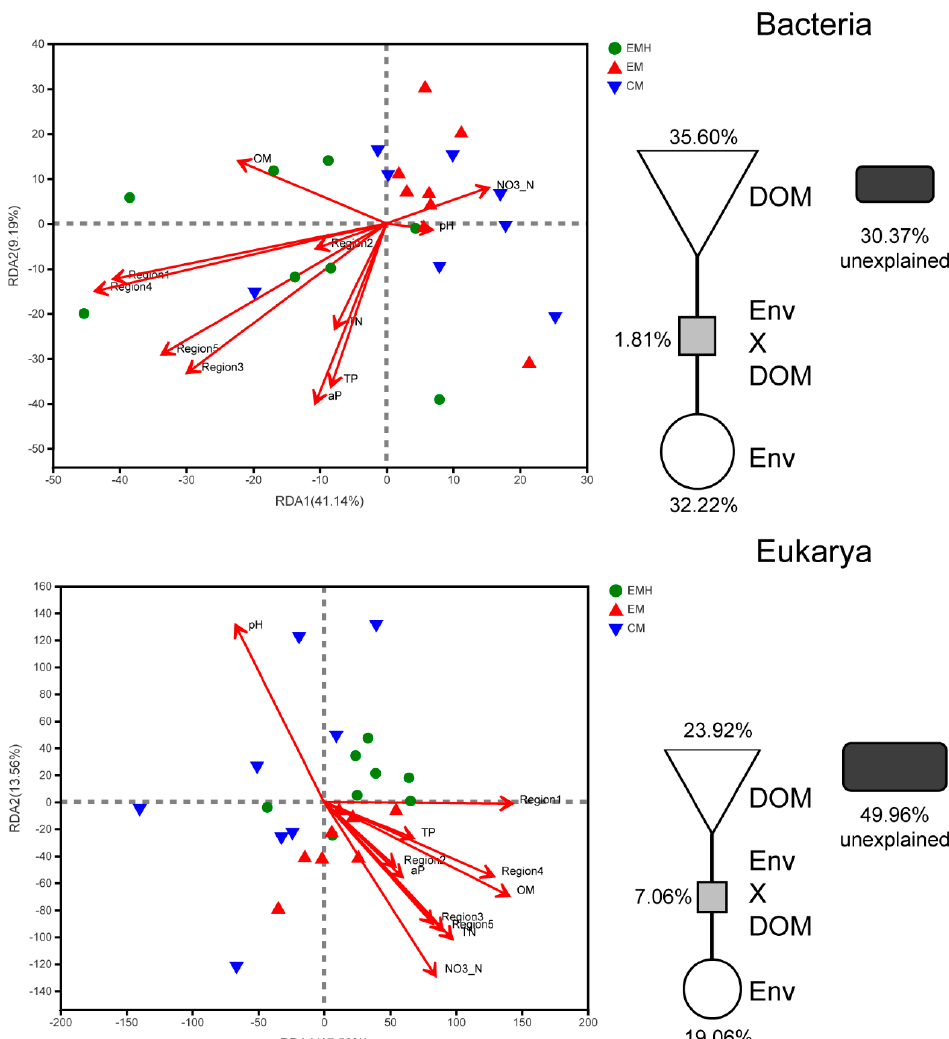
Figure 6. The redundancy analysis (RDA) and variance partitioning analysis (VPA) analysis showing the relationship between environmental factors, soil dissolved organic matter (DOM), and soil microbial communities.